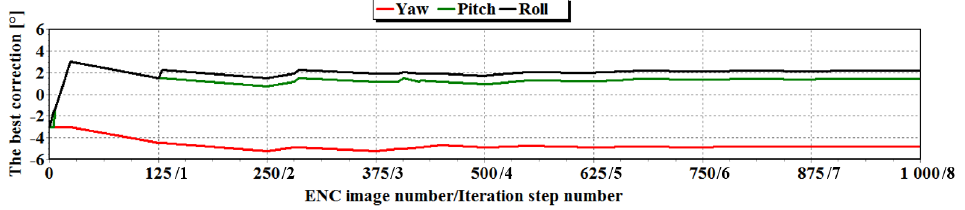
Figure 17. Graphs of the values of corrections of spatial orientation angles ( ∆ ψ cor , ∆ θ cor , ∆ φ cor ) during the iteration process for photograph No.